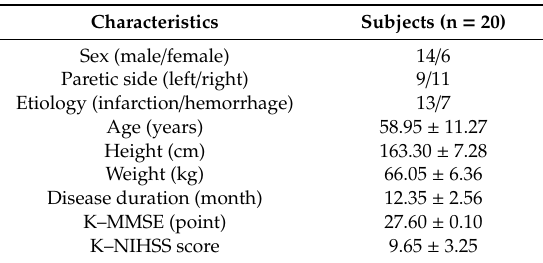
Table 1. Participant